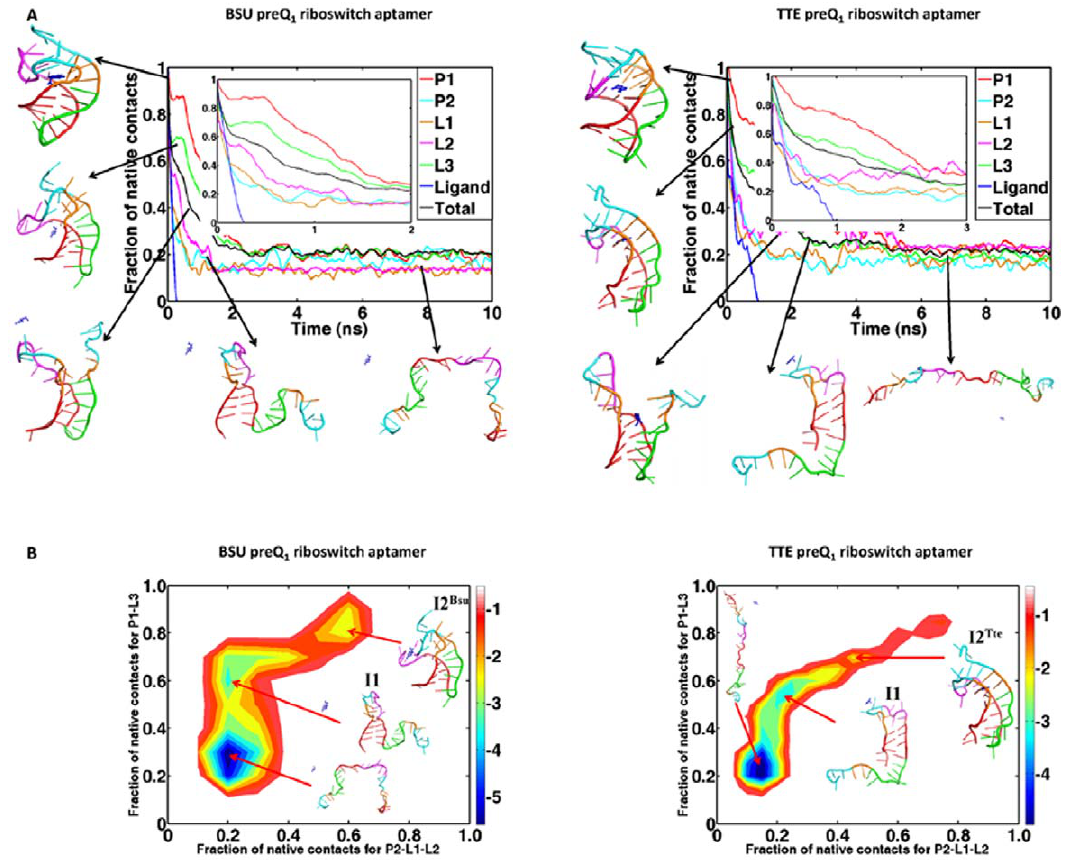
Figure 3. Unfolding pathways and free energy landscapes of Bsu and Tte preQ 1 riboswitch aptamers in presence of the ligands at 400 K: (A) the time evolution of the mean fraction of native contacts in the aptamer during the unfolding simulations. The different curves describe different parts; (B) the two-dimensional unfolding free energy landscapes. The order parameters are the fractions of native contacts for P1-L3 and P2-L1-L2, respectively. The surrounding structures are representatives of the conformations observed during the unfolding processes.